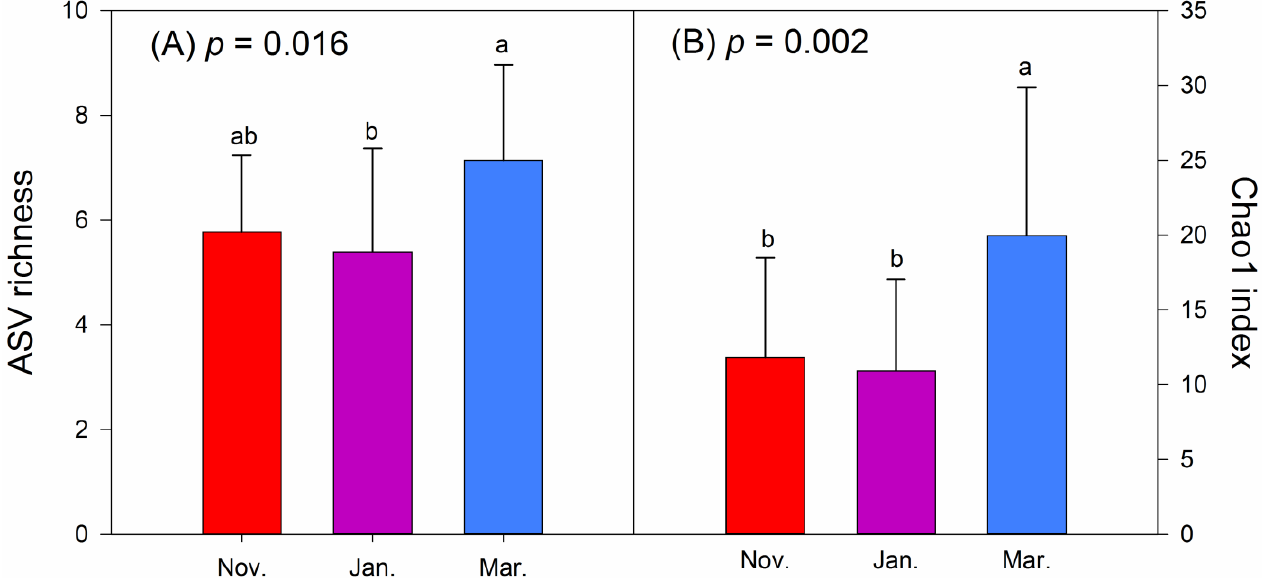
Figure 4. Alpha diversity of foods of wintering hooded cranes in the 3 months. ( A ) Shannon–Weiner index; ( B ) Simpson index. Letters over the bars indicate pairwise differences according to Tukey HSD test at the p < 0.05 level. Coloured bars indicate the mean value, and error bars represent the standard deviation.